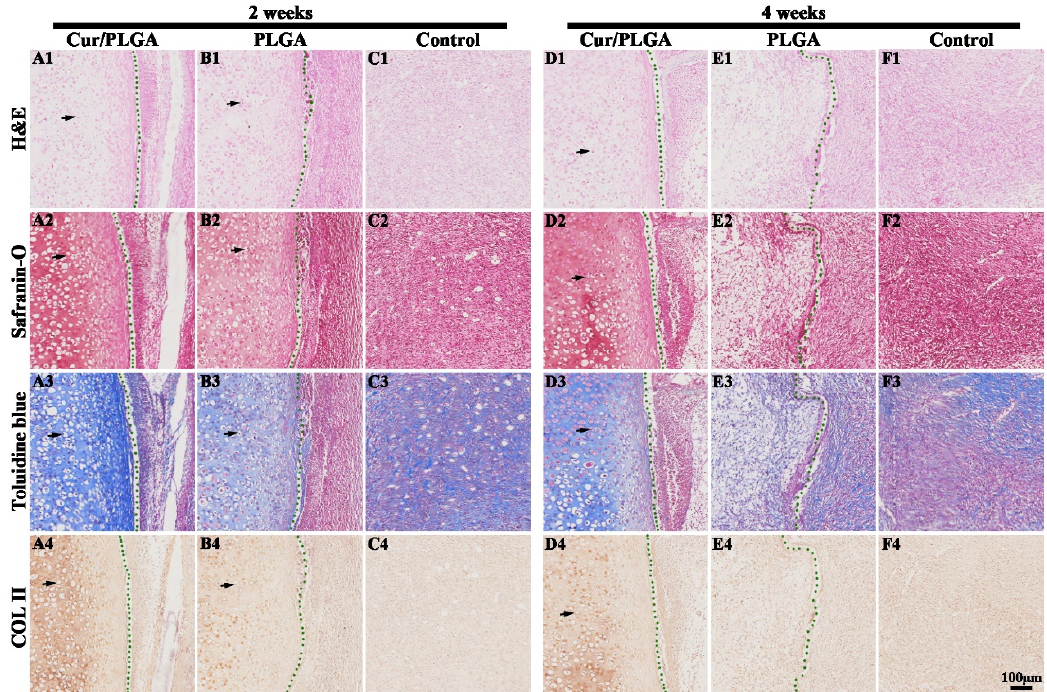
Figure 6. Histological evaluation of the nanofibrous-membrane-packaged cartilage tissue at weeks 2 and 4 after subcutaneous implantation in rats: Hematoxylin and eosin (H&E) staining of samples in the curcumin/poly(lactic-co-glycolic acid) (Cur/PLGA), PLGA, and control groups ( A1 – F1 ). Safranin-O staining of samples in the Cur/PLGA, PLGA, and control groups ( A2 – F2 ). Toluidine blue staining of samples in the Cur/PLGA, PLGA, and control groups ( A3 – F3 ). COL II immunohistochemical staining of samples in the Cur/PLGA, PLGA, and control groups ( A4 – F4 ). The black arrows indicate the cartilage-specific extracellular matrix (ECM). The dotted green lines outline the nanofibrous membrane, while the remaining region represents the cartilage.